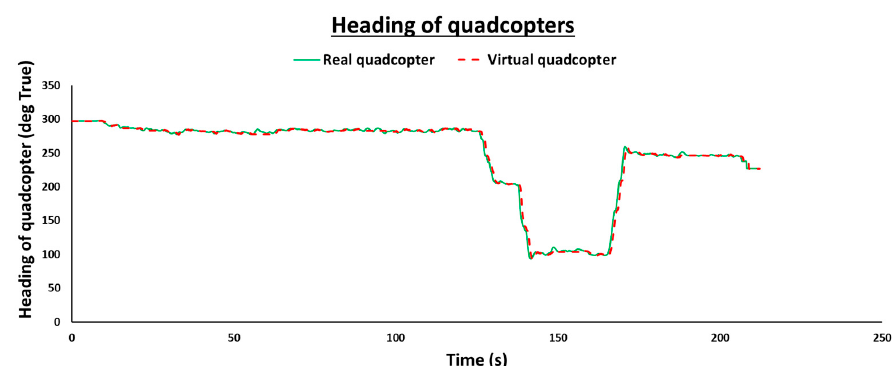
Figure 26. Heading comparison of the real and the virtual quadcopters.